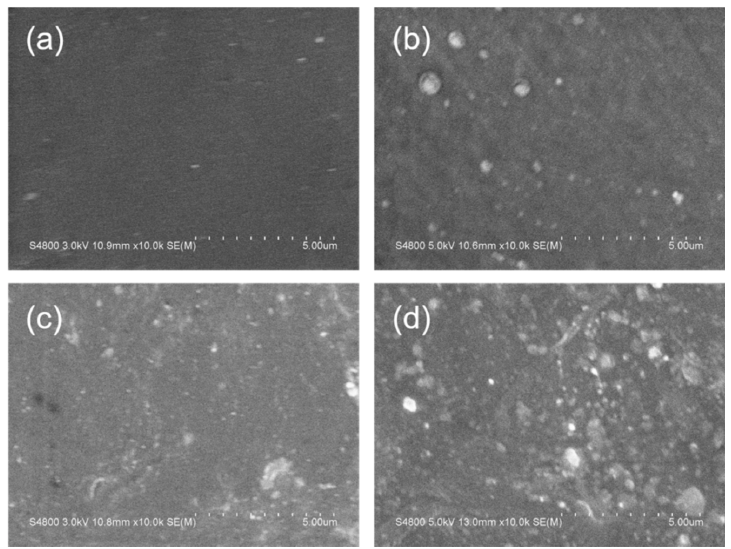
Figure 4. SEM images of PP-H-PAAS surfaces; ( a – d ) were the smooth surfaces of specimen 1, 2, 3, 4, respectively.